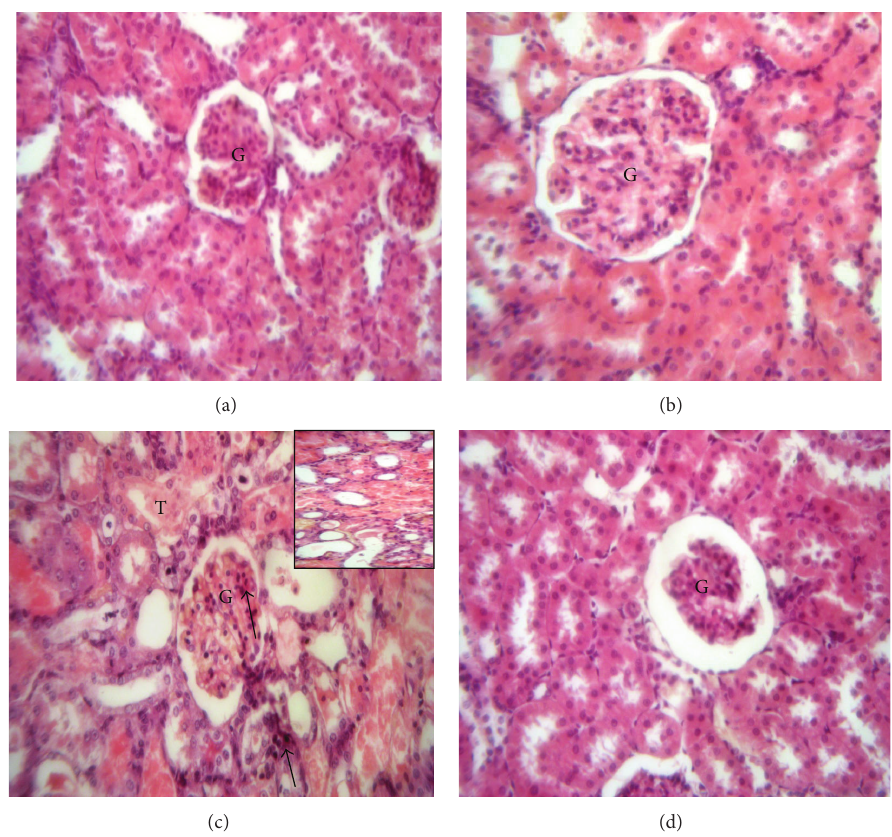
Figure 1: Effect of sildenafil on kidney histopathological picture of gentamicin-induced nephrotoxicity in rats (H&E × 400). A representative photomicrograph of a section in the kidney cortex of (a) and (b) control and sildenafil-treated groups, respectively, showing normal structure of renal glomerulus (G) and renal tubules, (c) gentamicin-treated group showing degeneration and necrobiosis in the epithelial cells lining the renal tubules (T), with apoptotic morphology with pyknotic nuclei in some cells of the renal glomerulus and tubules (arrows) and cystic luminal dilatation in some tubules (inset), and (d) gentamicin- and sildenafil-treated group showing regular epithelial cells lining the tubules with normal morphology of renal